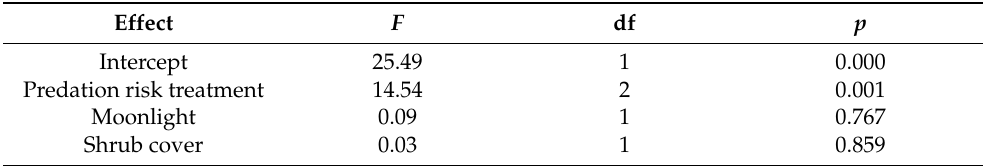
Table 1. Results of the GLM analyzing the effect of experimental and environmental factors on Abrothrix spp. feeding